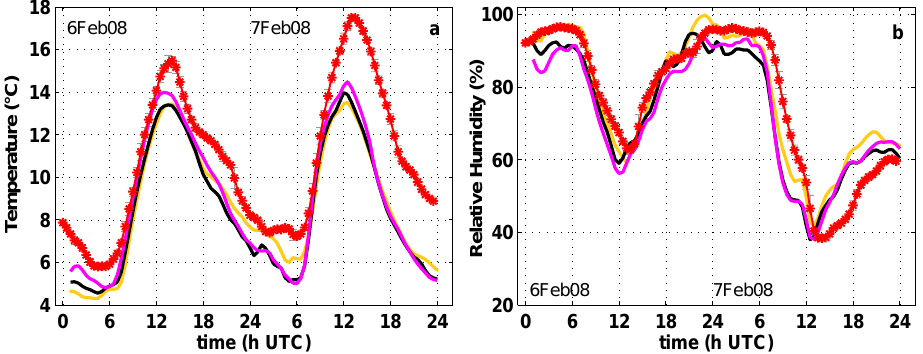
Fig. 6. Time series for temperature (a) and relative humidity (b) for 6–7 February 2008. Color code: MYJtd is orange; MYJNoahNOURB is black; MYJNoahUCM2 is pink; measurements by probes combined with the sonic anemometer are red; and errors are